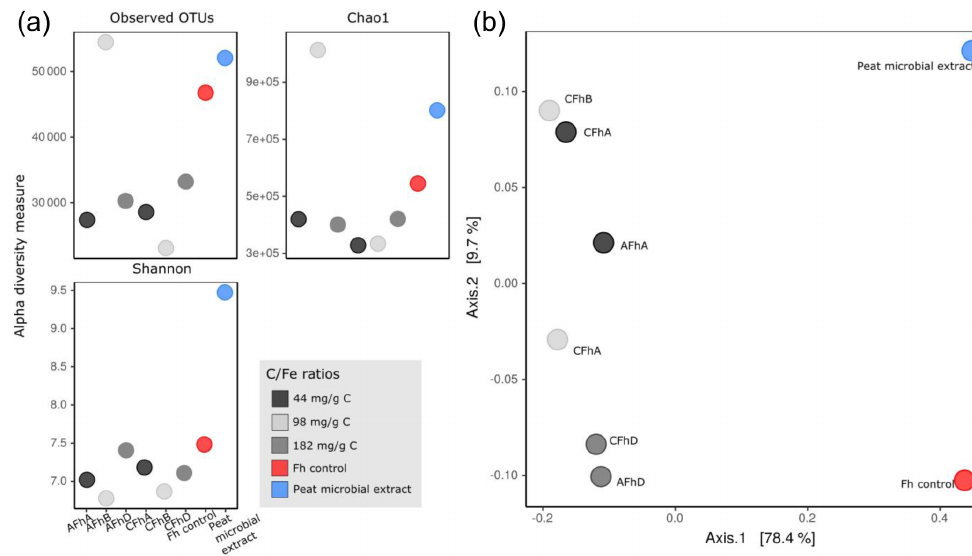
Figure 4. Alpha and beta diversity analyses. Alpha diversity analysis was done using various indices indicative for diversity (observed OTUs, Chao1) and evenness (Shannon) (a) . Alpha diversity in general describes within-data set diversity. Observed OTUs refers to OTU counts based on the OTU definition given in the materials and methods. Chao1 (Chao, 1984) is an index that puts special emphasis on rare taxa to extrapolate the real number of OTUs based on observed OTUs. The Shannon index (Shannon, 1948) describes the entropy in a community profile, and reaches its maximum when taxonomic groups are evenly distributed in a data set. Beta diversity (differences in diversity between samples) analysis was based on Jensen–Shannon divergences (Koren et al., 2013) (b)